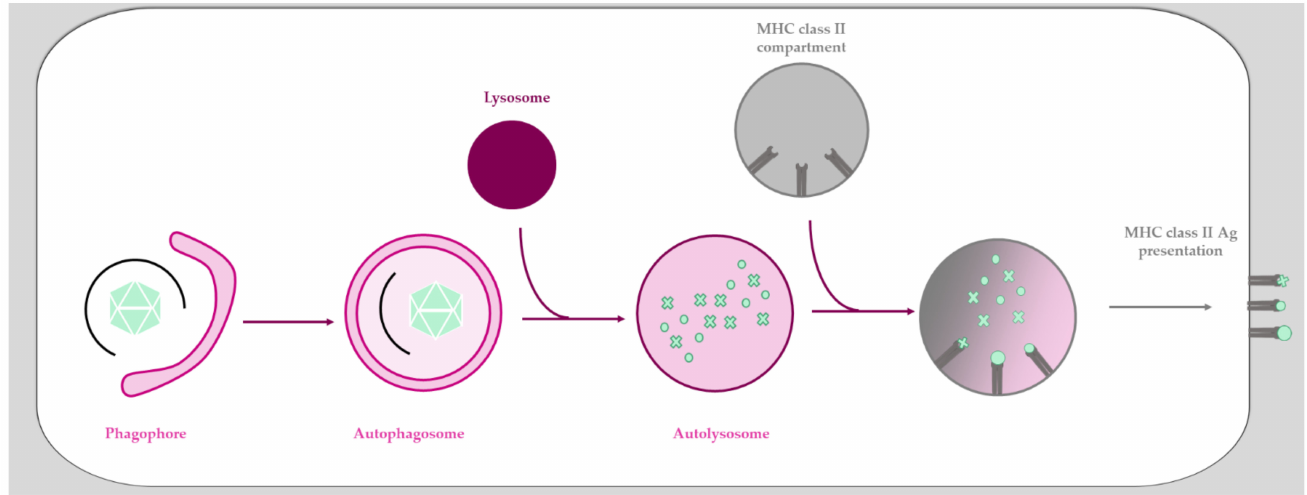
Figure 2. MHC class II presentation by autophagy. Autophagy starts with the formation of a double membrane structure called phagophore that will elongate around the cargo to form a double-membrane vesicle called autophagosome. After fusion with lysosome, the cargo will be degraded in a so-called autolysosome. Further fusion of this vesicle with MHC class II compartment allows the loading of peptides for the ensuing MHC class II antigen